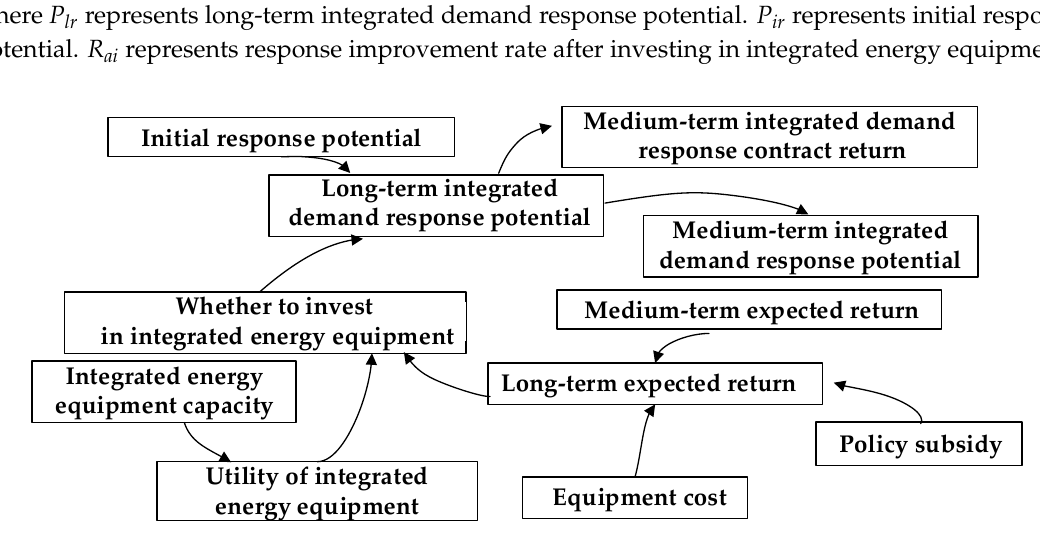
Figure 3. Long-term integrated demand response decision module stock flow chart.